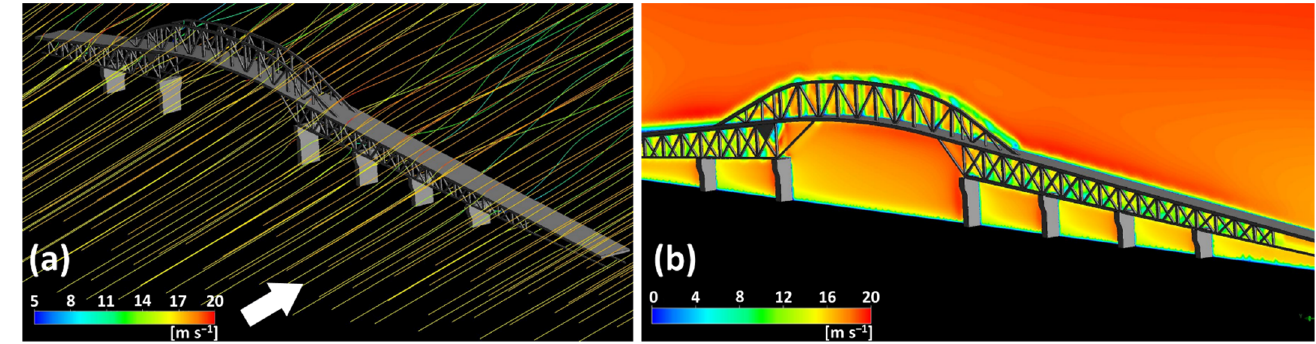
Figure 7. Overall airflow behaviour around the harbour for the westerly wind: ( a ) velocity streamlines; ( b ) contour of mean speed at the centre of the harbour.